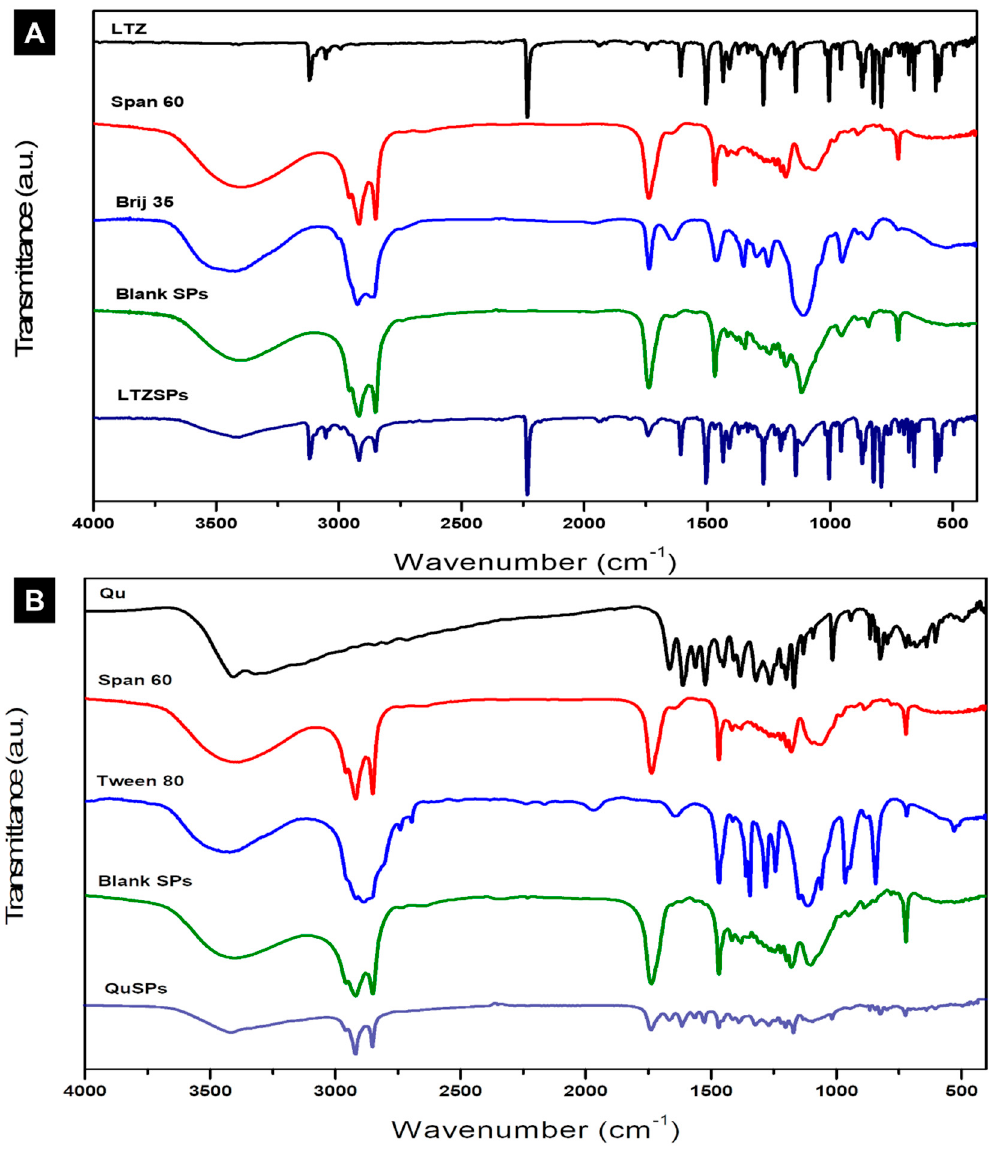
Figure 2. FTIR spectra of ( A ) letrozole (LTZ), Span 60, Brij 35, blank spanlastics (Blank SPs), and letrozole loaded spanlastics (LTZSPs, formulation L8). ( B ) Quercetin (Qu), Span 60, Tween 80, blank spanlastics (Blank SPs), and quercetin-loaded spanlastics (QuSPs, formulation Q5).